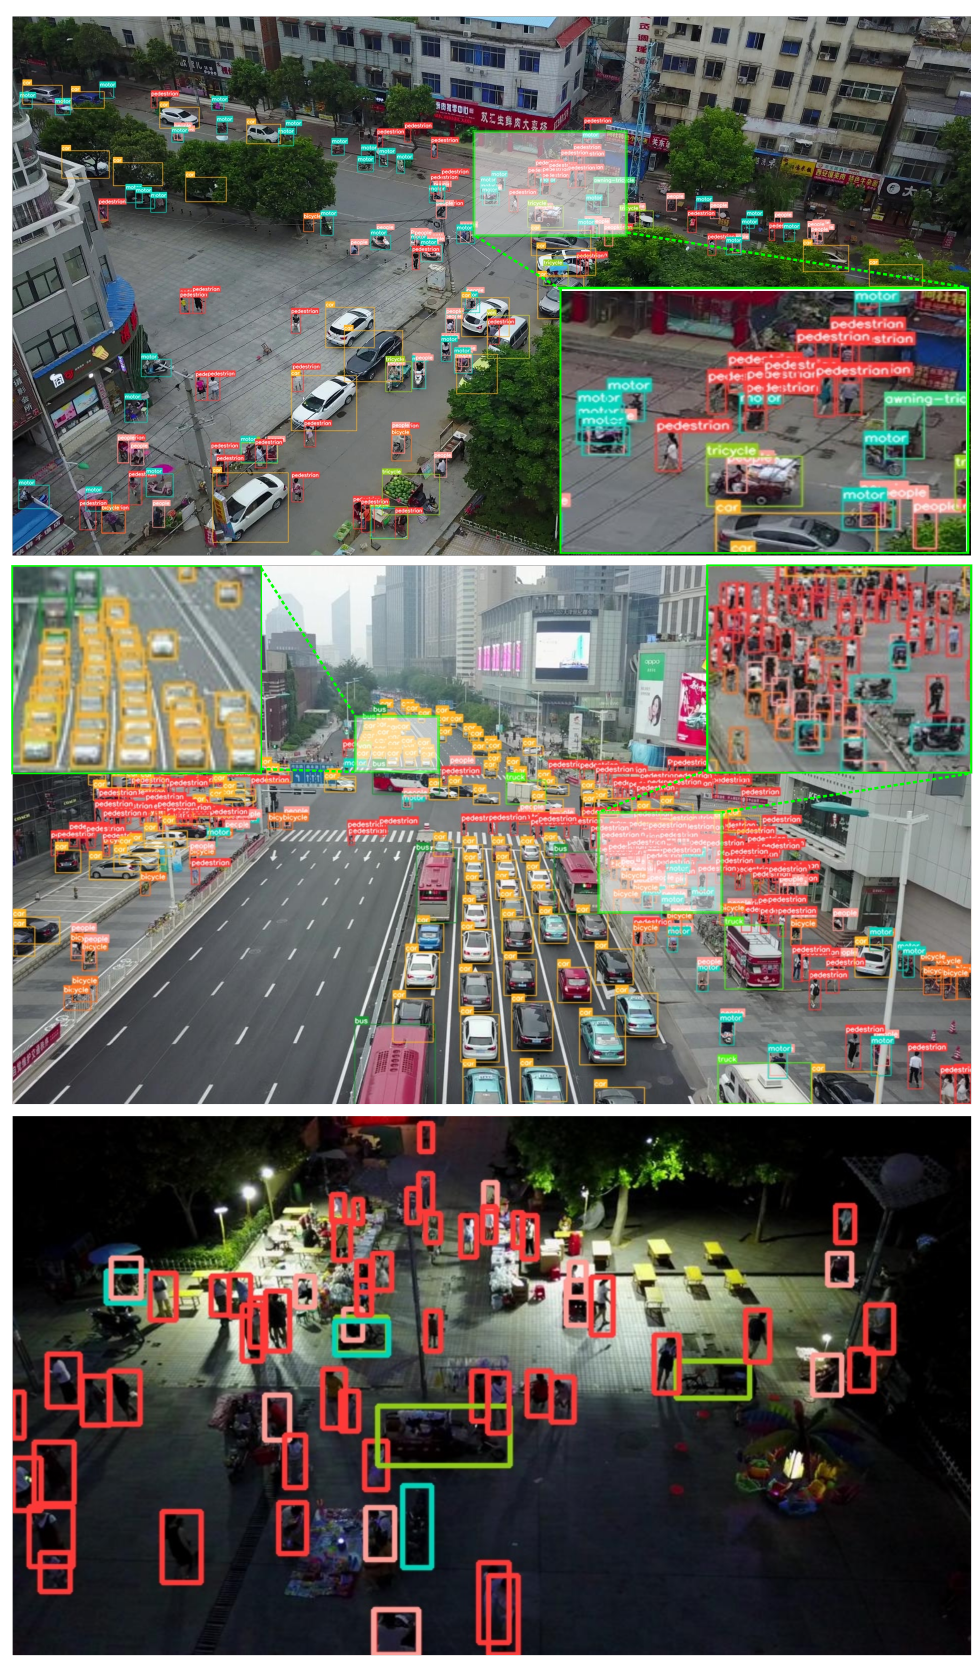
Figure 13. Visualization of the results obtained with our FiFoNet on large or low-light scenes. Note the zoomed-in views of the crowded areas highlighted in green